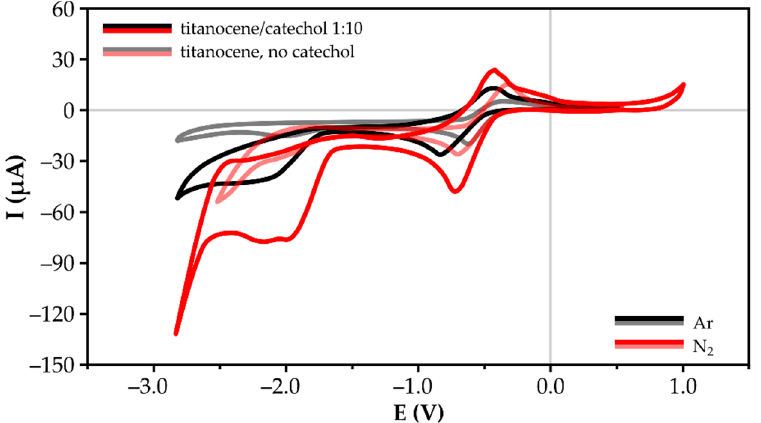
Figure 2. Comparison of cyclic voltammograms of Cp 2 TiCl 2 (2 mM) working solution in a solvent mixture THF/MeOH 9:1 with 0.1 M n-Bu 4 NClO 4 under N 2 or Ar, with or without 20 mM catechol.